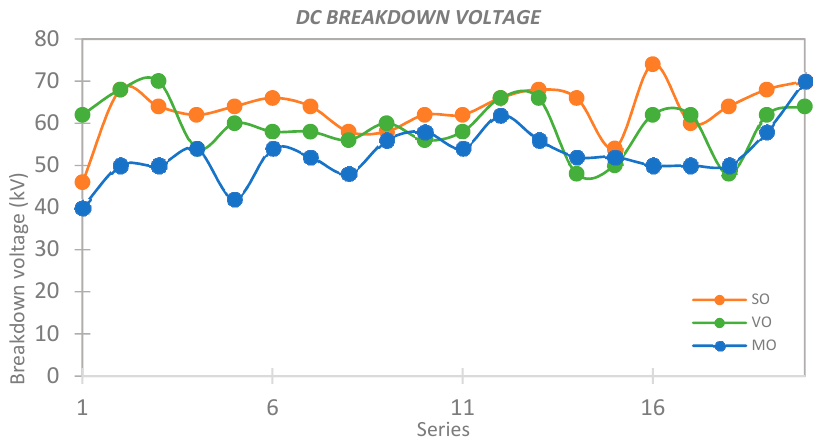
Figure 3. Distribution of DC breakdown voltages of mineral oil (MO), vegetable oil (VO), and synthetic oil (SO).